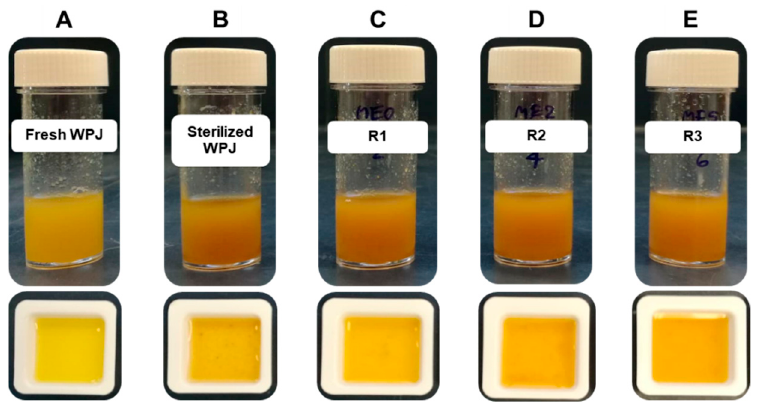
Figure 4. Appearance of the fresh whole pineapple juice (WPJ) prior to sterilization ( A ); the sterilized whole pineapple juice ( B ); the fermented whole pineapple juice Recipe 1 (R1) at 12 h ( C ); the fermented whole pineapple juice Recipe 2 (R2) at 12 h ( D ); the fermented whole pineapple juice Recipe 3 (R3) at 12 h ( E ). The electronic color parameters (L*, a*, and b*) of the fermented juice products R2, R2-E1 and R2-E2, are shown in Table 1. The data are for various times during refrigerated